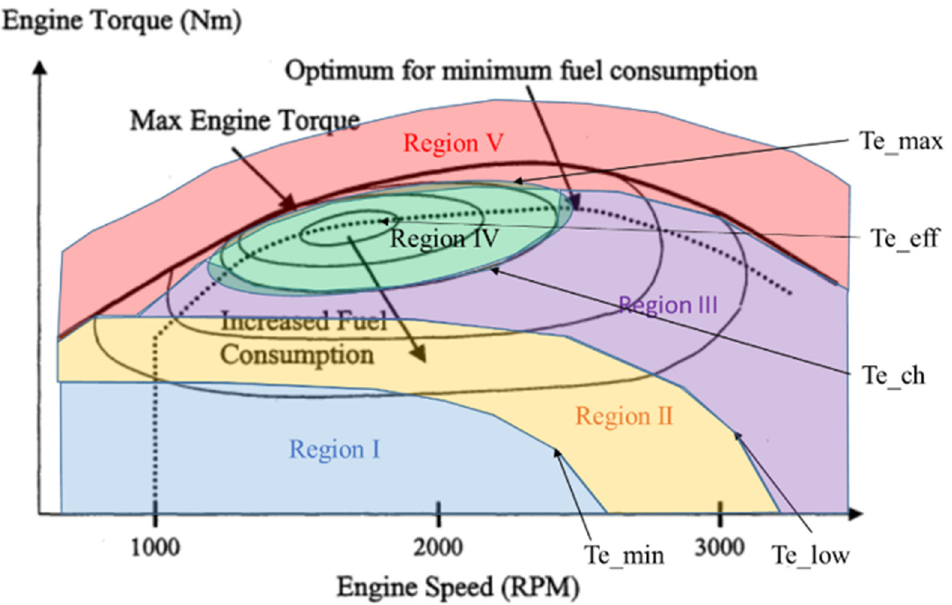
Figure 3. System operation region division from engine map for parallel HEVs.